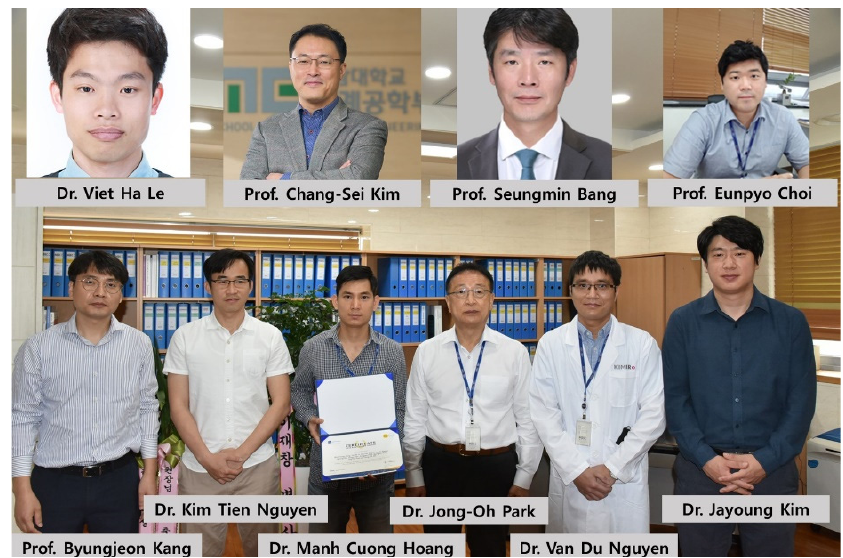
Figure 3. Chang-Sei Kim Team.